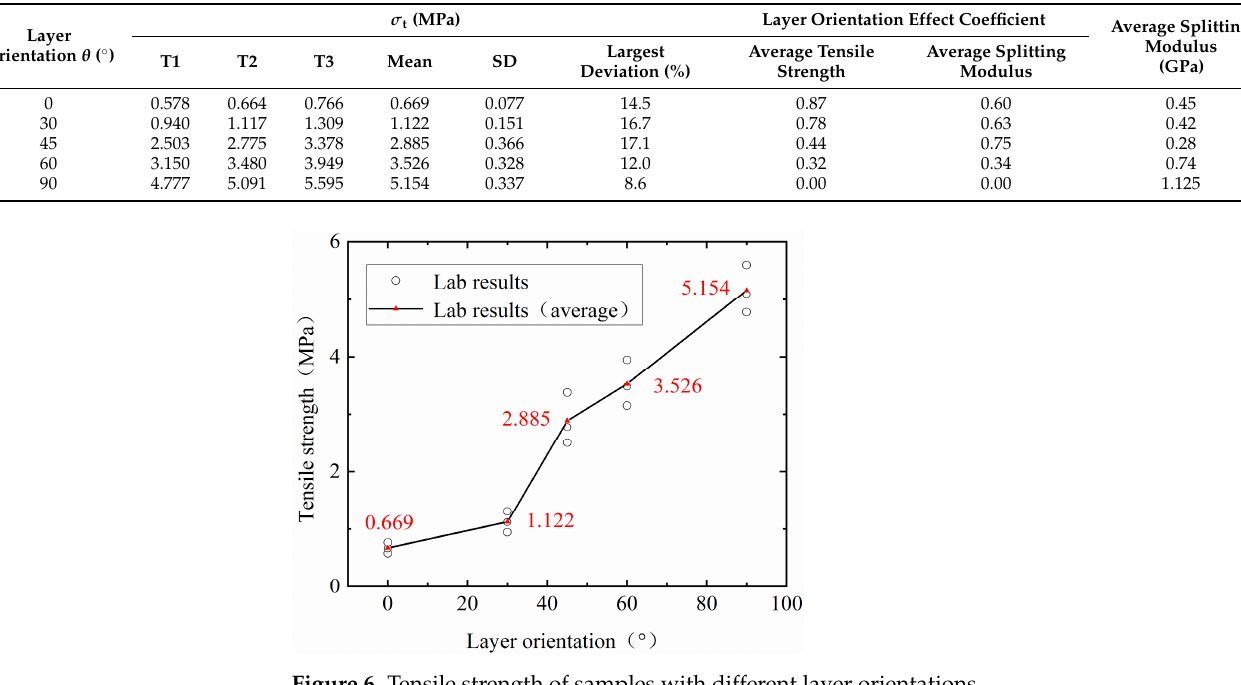
Table 3. Tensile strength and layer orientation effect coefficient of continental shale.